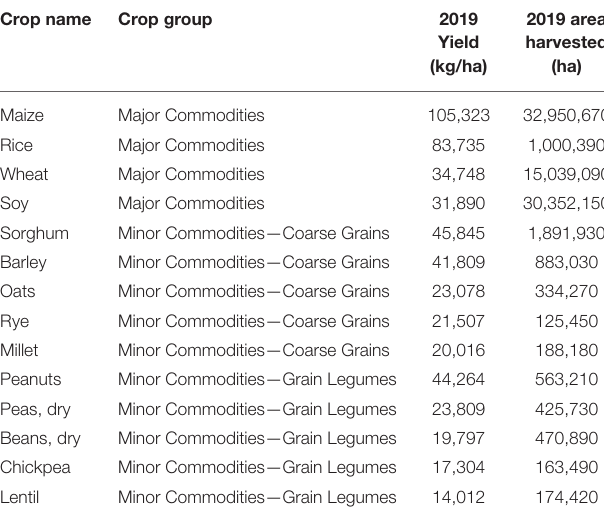
TABLE 1 | Crop group classifications, and yield and area harvested per crop in the United